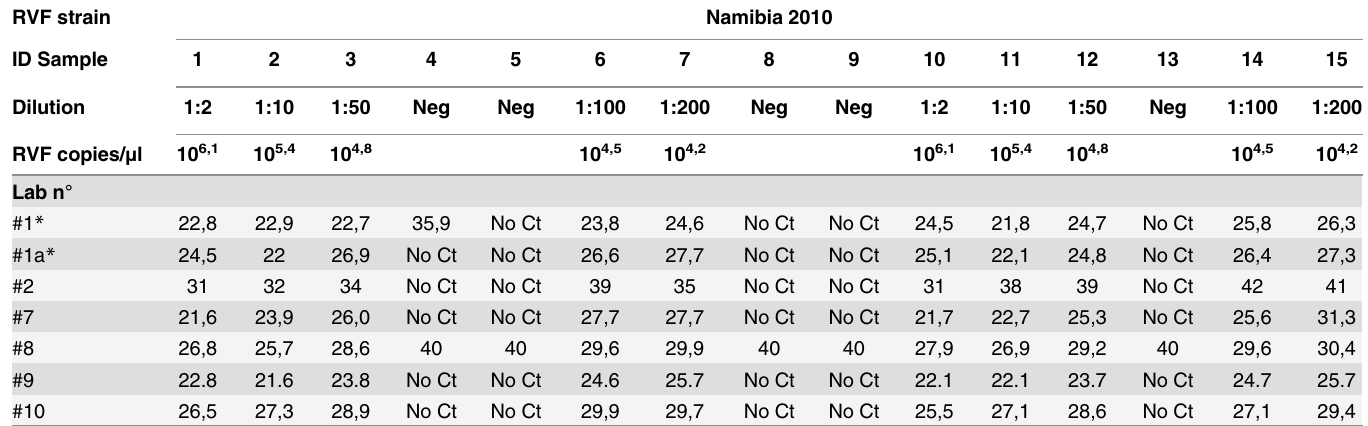
Table 2. Results of the EQA for RVFV virus genome detection, cycle threshold (Ct)